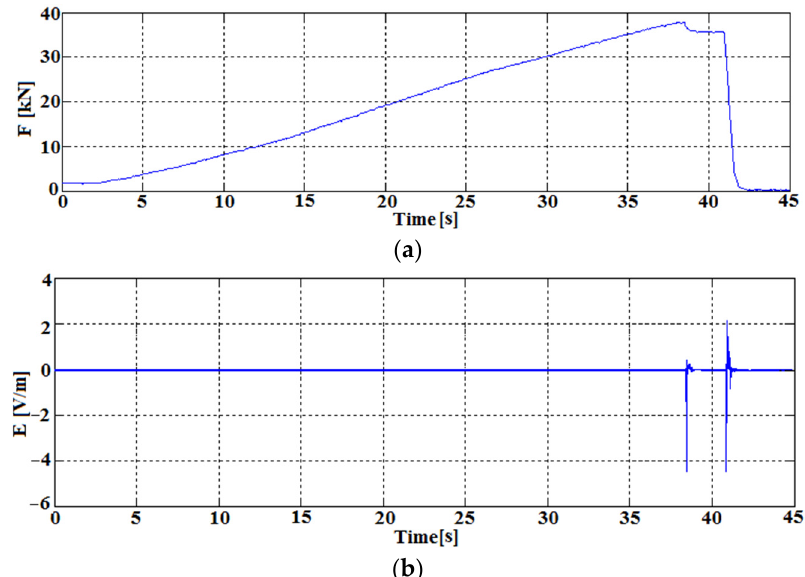
Figure 10. Electromagnetic emission tests on a laboratory test bench. ( a ) time course of the compres- sive force on the hard coal sample; ( b ) time course of the electric component of the electromagnetic field.